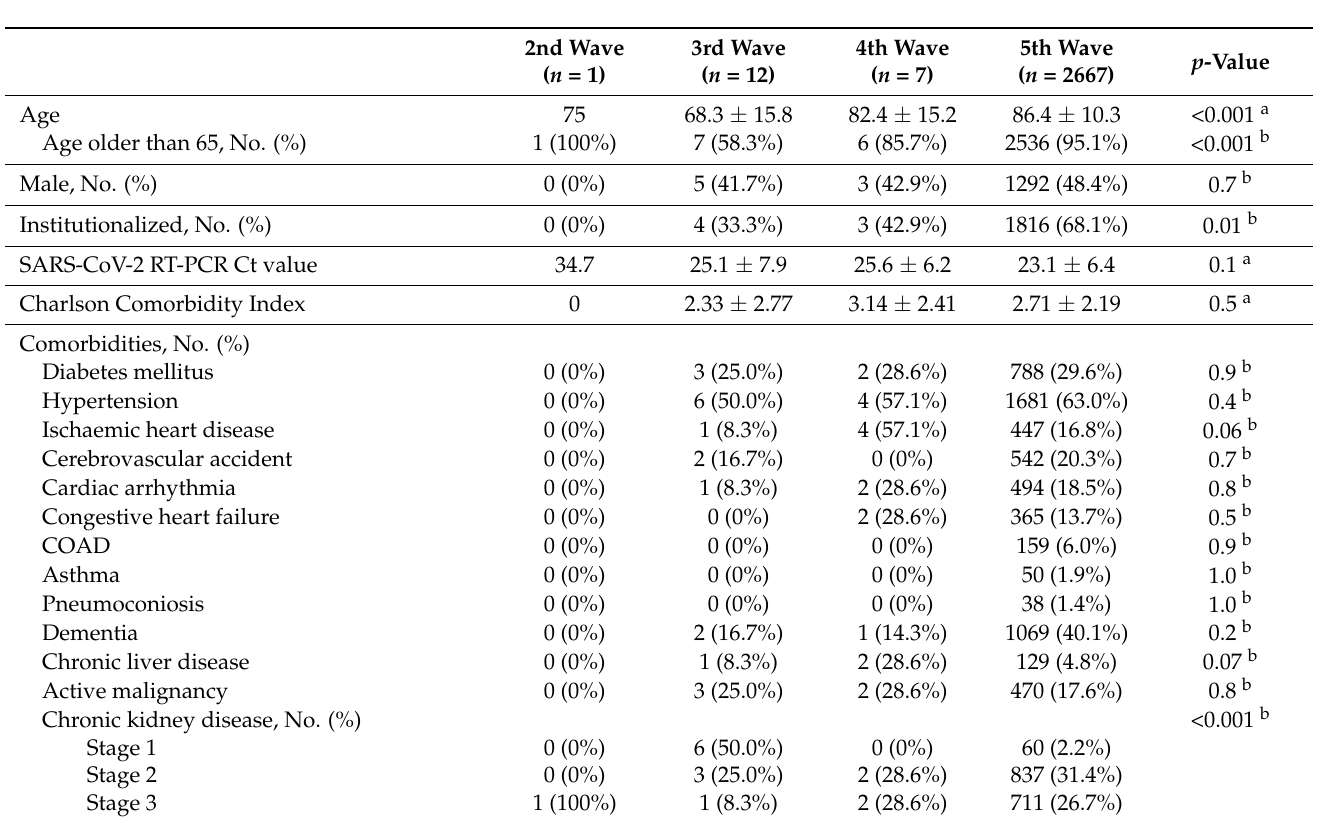
Table 7. Clinical characteristics of COVID-19 patients with hypernatraemia at presentation during the different local waves of